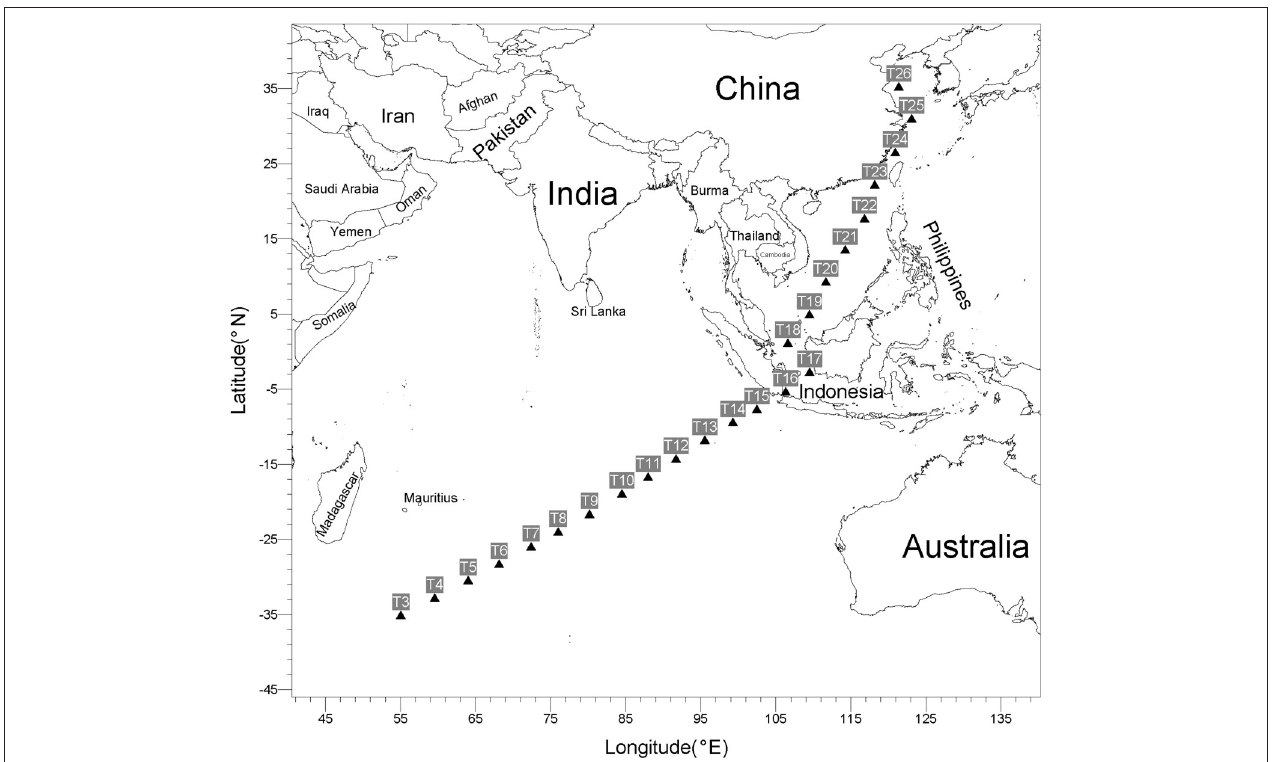
FIGURE 1 | Location of the sampling sites during the DY125-30